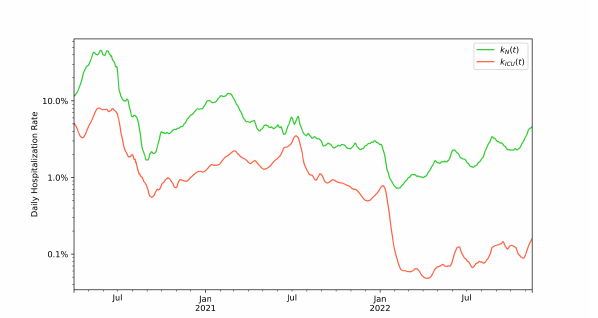
Figure 4. Estimated daily hospitalisation rates. The lines indicate the estimate of the hospitalisation rate for a moderately severe disease course (green) and a severe disease course (red). Estimates are based on a 7-day moving window and displayed with logarithmic scaling.